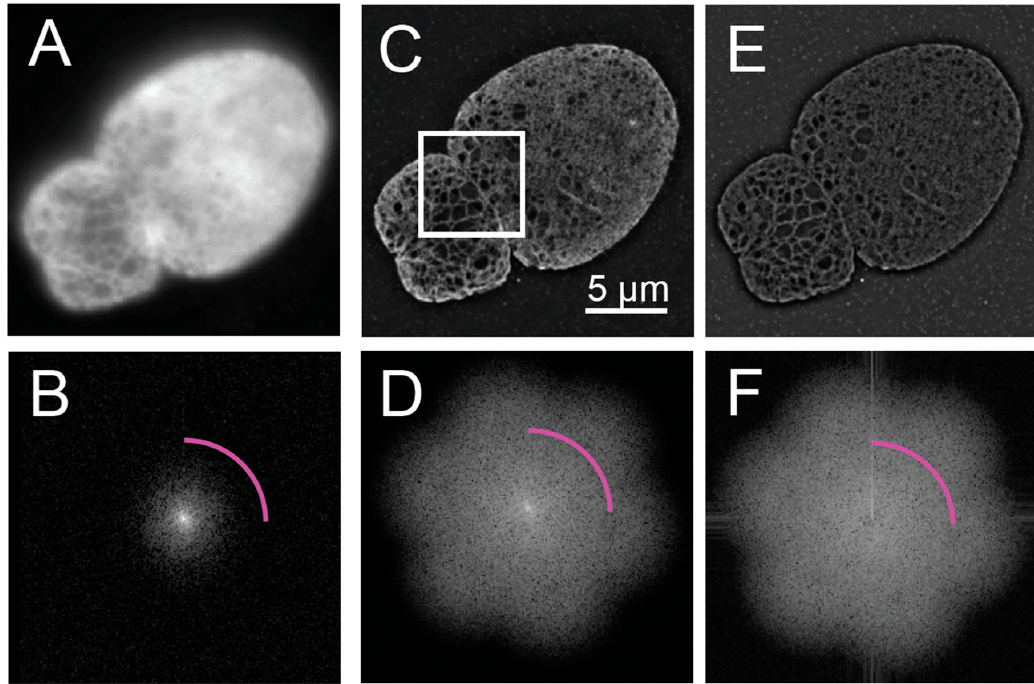
Figure 1. Structured Illumination Microscopy and Reconstruction of an Image of Lmnb1 − / − Mouse EmbryonicFibroblast. Fifteenframes, consistingofthreeanglesandfiveorientations, fora3D-Structured Illumination Microscopy (SIM) image were acquired of the nucleus of a Lmnb1 − / − mouse embryonic fibroblast (MEF) as part of a z-stack. The frames from a single z-slice were averaged to produce a widefield image ( A ) and the two-dimensional Fourier transform of the widefield image ( B ), showing the di ff raction-limited resolution of widefield microscopy. The fifteen frames were processed into a reconstructed 3D-SIM image ( C ) and its two-dimensional Fourier transform ( D ). The ratio of (C) over (A) is computed by pixel-by-pixel division to show contrast enhancement of features in structured illumination microscopy (SIM) over widefield microscopy along with its two-dimensional Fourier Transform ( F ) of ( E ), showing retention of structural coe ffi cients with reduced low frequency contribution. Magenta arcs in (B), (D), and (F) indicate resolution cut-o ff limit at 250 nanometers. Fourier Transforms are shown as a log (magnitude + 1). The white scale bar indicates 5